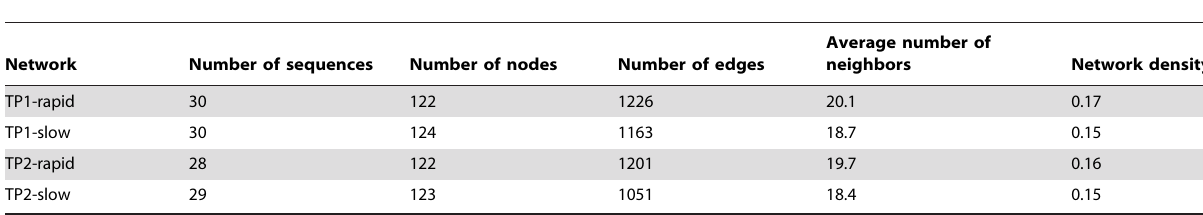
Table 9. Basic amino acid covariance network parameters for the rapid and slow progressor sequences.